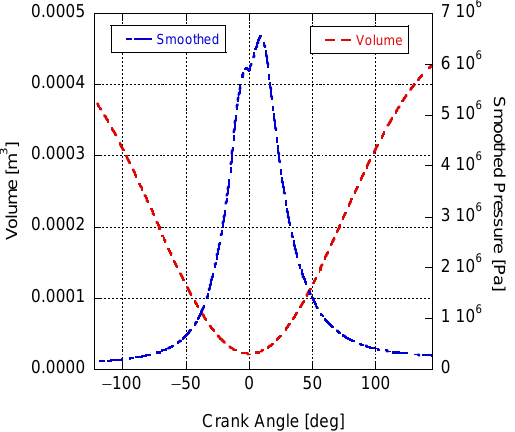
Figure 1. Smoothed pressure data and the cylinder volume as a function of crank angle.